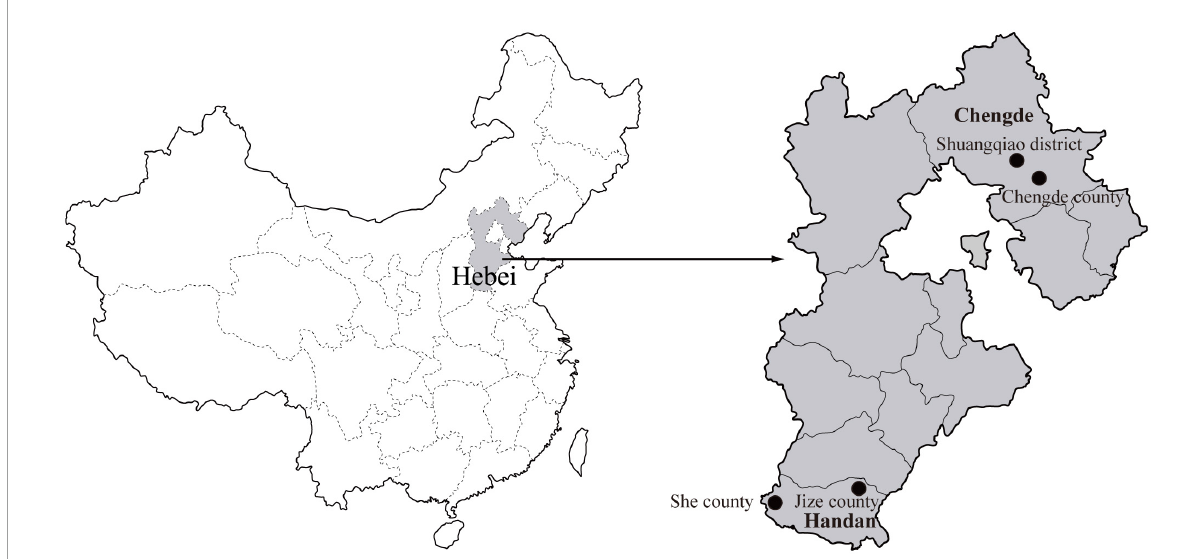
FIGURE1 Geographical distribution of the rodent sampling sites (black dots) in Hebei Province, China. The map of China was obtained freely from http://english.freemap.jp/item/asia/china.html. The map of Hebei Province was generated using ArcGIS.